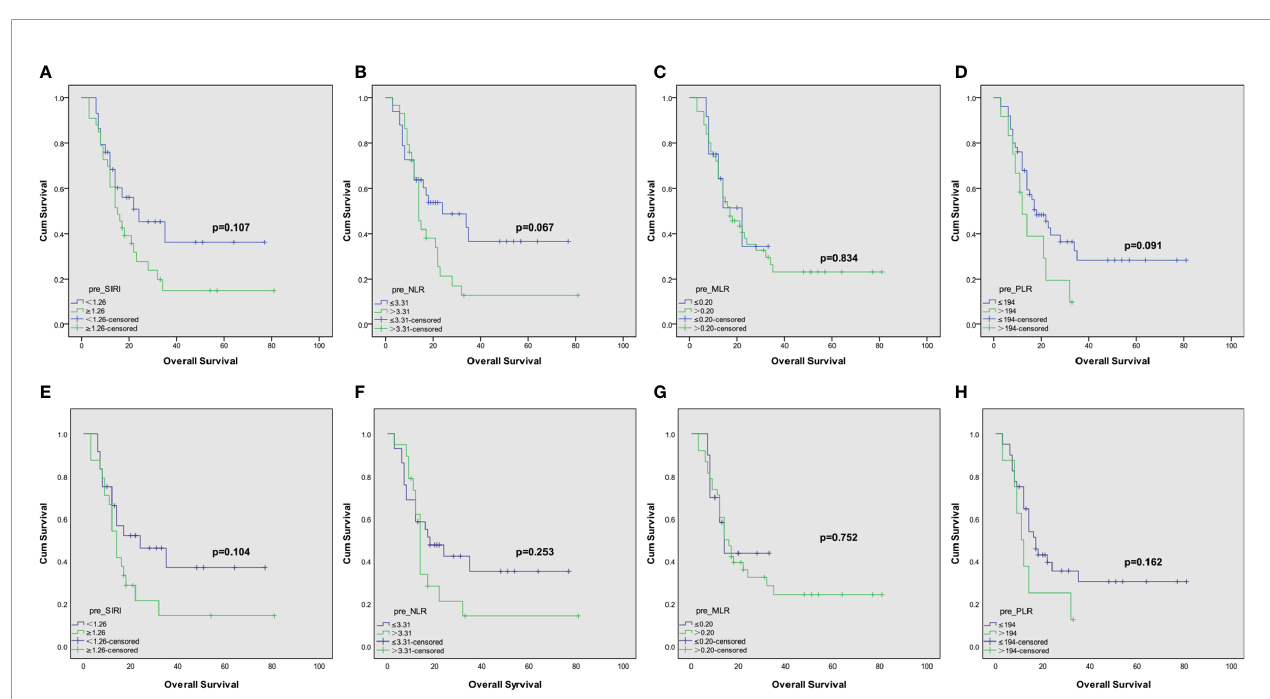
FIGURE 1 | Kaplan – Meier curves for patients strati fi ed based on (A) SIRI, (B) NLR, (C) MLR and (D) PLR in operable grade IV glioma patients in complete dataset. And Kaplan – Meier curves for patients strati fi ed based on (E) SIRI, (F) NLR, (G) MLR and (H) PLR in operable grade IV glioma patients after propensity matching.